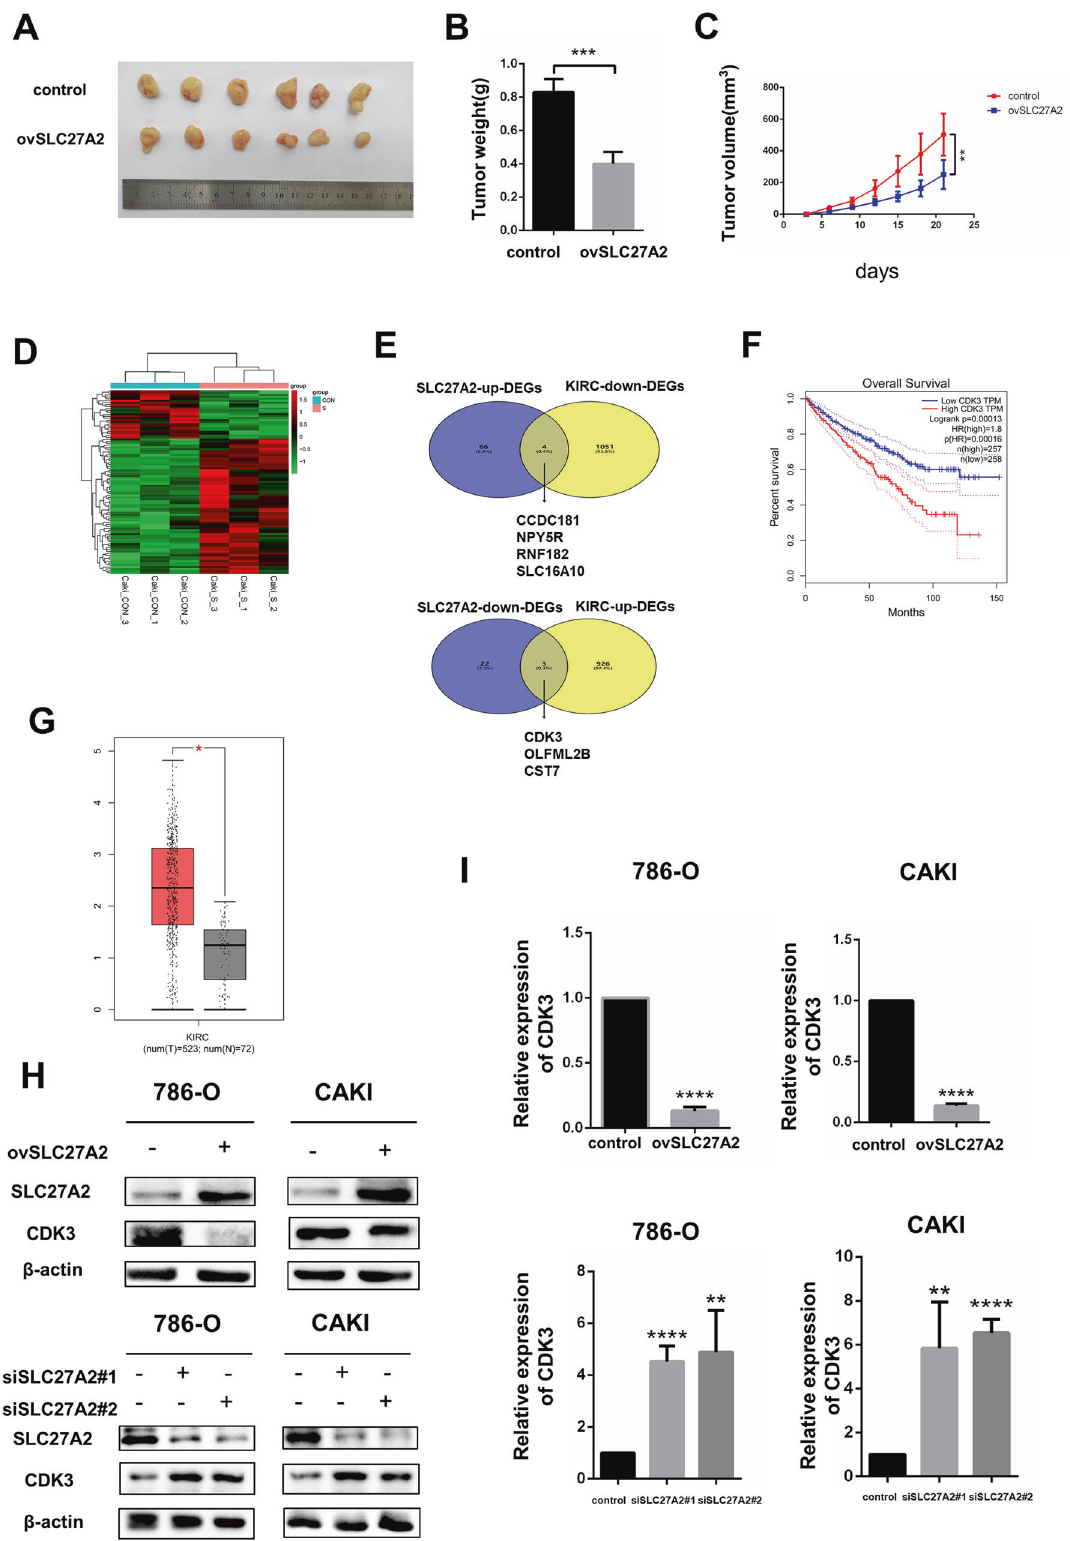
SLC27 A2 promoted EMT signaling and ccRCC metastasis in a CDK3-mediated manner Based on the above experimental results, we proposed that SLC27A2 in fl uences ccRCC development by affecting